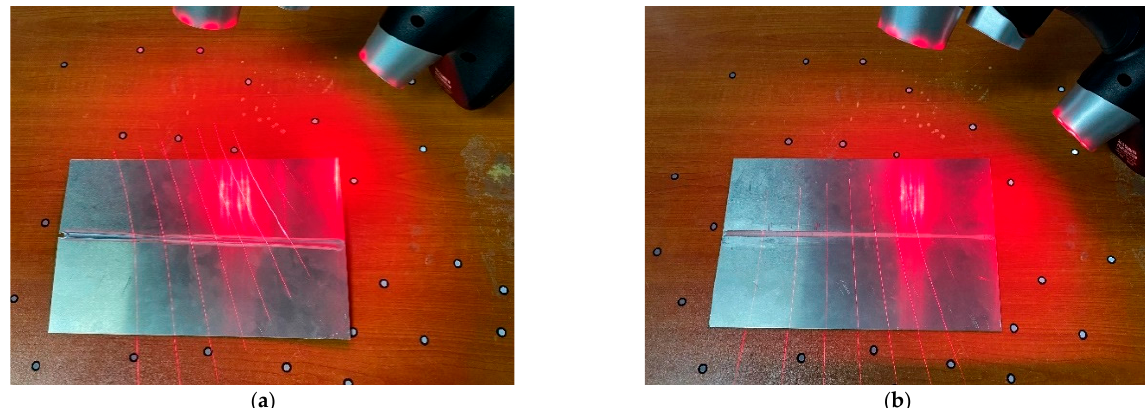
Figure 15. Laser scanning of an LY12 aluminum alloy welding specimen under different conditions: ( a ) conventional welding; ( b ) welding with a trailing hybrid high-speed gas fluid field.